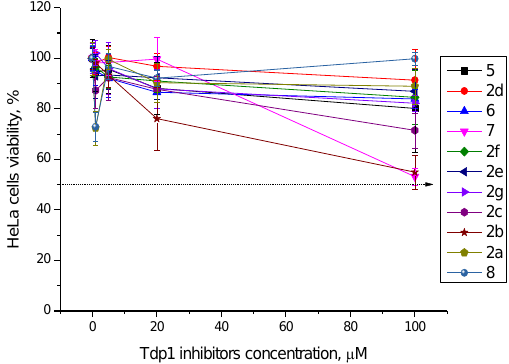
Figure 1. Dose-dependent action of the lipophilic pyrimidine nucleosides on HeLa cell viability measured in the EZ4U assay.